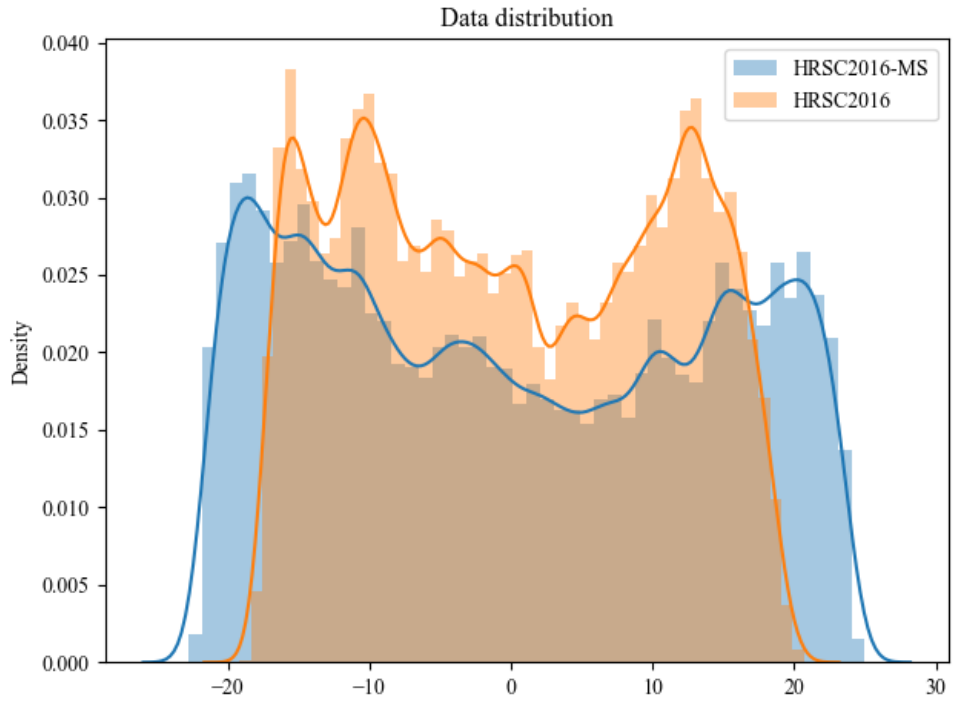
Figure 3. Data distribution of original HRSC2016 and proposed HRSC2016-MS